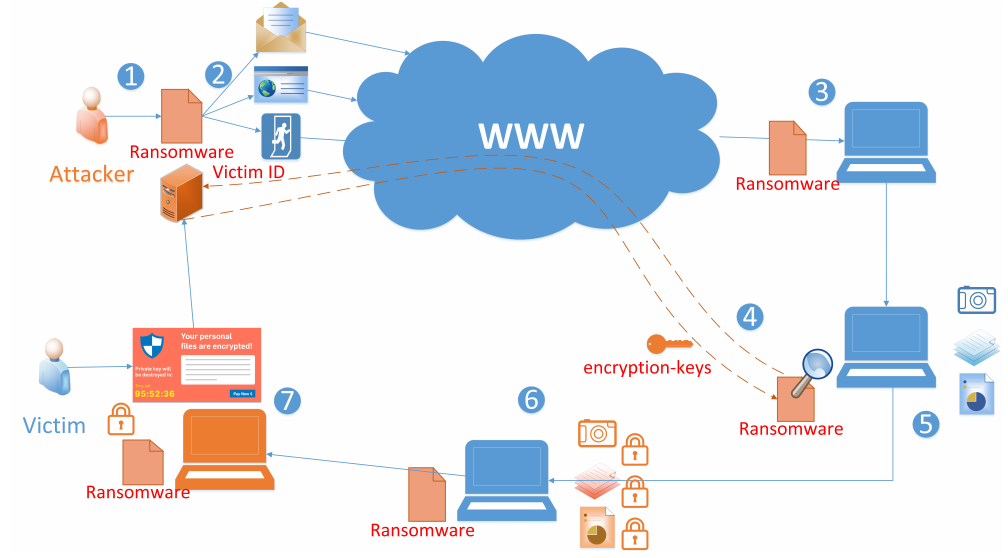
Figure 1. Steps of ransomware life